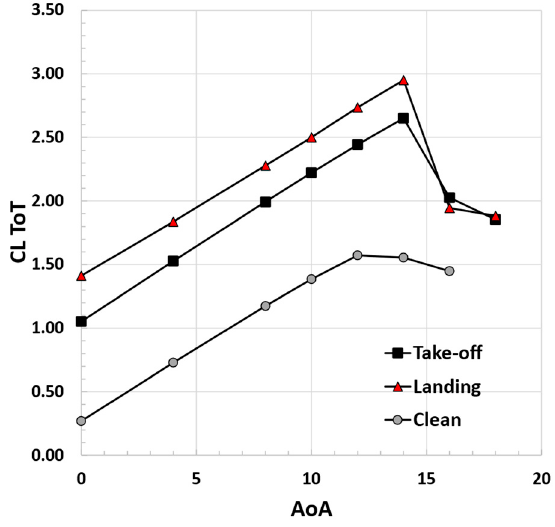
Figure 19. Total lift coefficient curves for clean and flapped (take-off and landing setup) wing configurations, low-speed conditions, M = 0.15, Re = 5.7 × 10 6 .